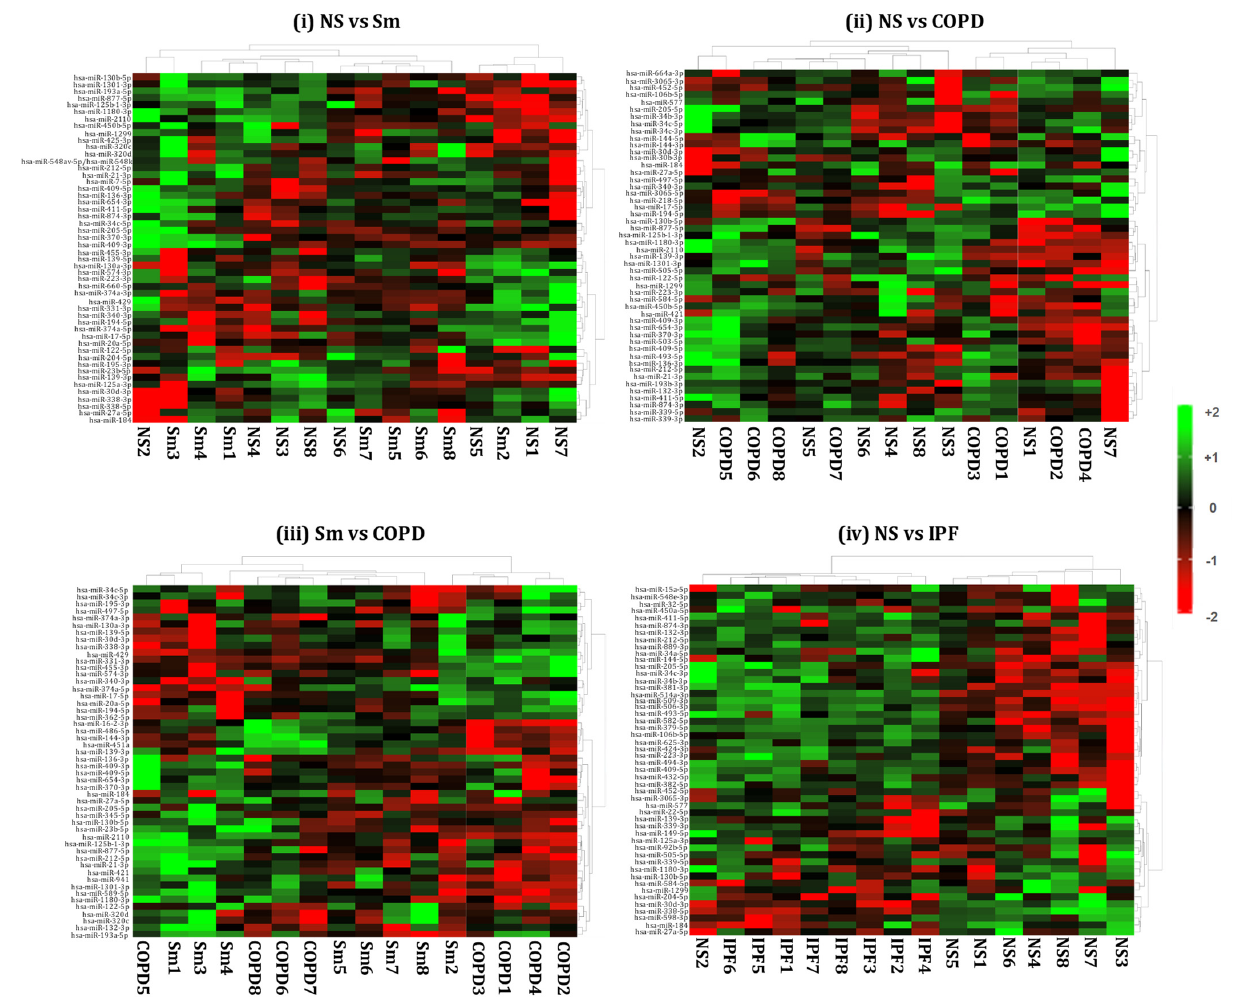
Figure 7. Hierarchical cluster analyses of differentially expressed miRNAs from lung-tissue-derived exosomes. Heat maps Figure 7 . Hierarchical cluster analyses of differentially expressed miRNAs from lung ‐ tissue ‐ derived exosomes. Heat maps showing top 50 variable miRNAs that are differentially expressed in the lung ‐ tissue ‐ derived exosomes from ( i ) healthy showing top 50 variable miRNAs that are differentially expressed in the lung-tissue-derived exosomes from ( i ) healthy non ‐ smokers (NS) vs. healthy smokers (Sm), ( ii ) healthy non ‐ smokers (NS) vs. COPD patients (COPD), ( iii ) healthy smok ‐ non-smokers (NS) vs. healthy smokers (Sm), ( ii ) healthy non-smokers (NS) vs. COPD patients (COPD), ( iii ) healthy smokers ers (Sm) vs. COPD patients (COPD), and ( iv ) healthy non ‐ smokers (NS) vs. IPF patients (IPF). (Sm) vs. COPD patients (COPD), and ( iv ) healthy non-smokers (NS) vs. IPF patients